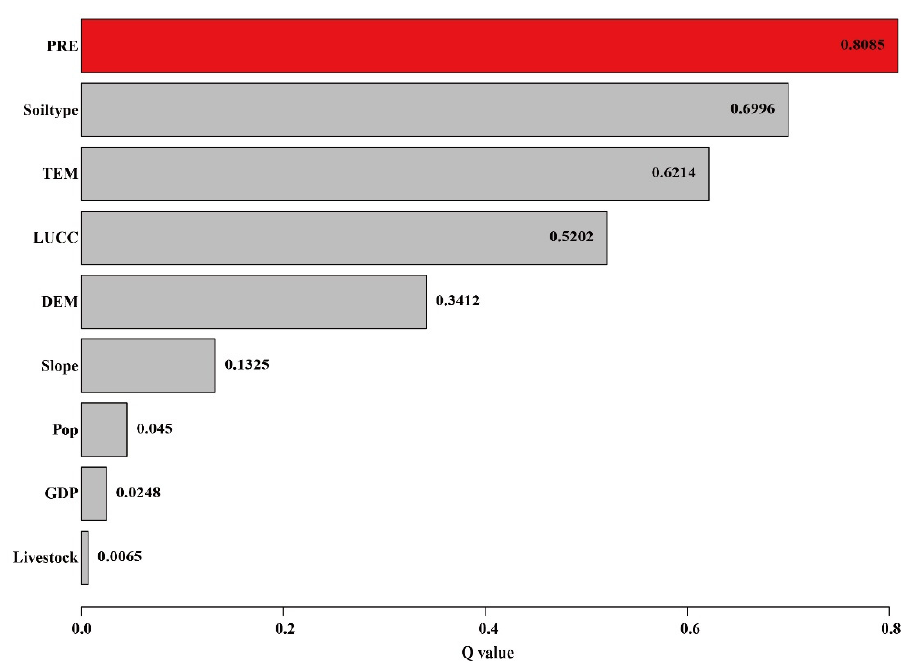
Figure 9. Factor detector results for each factor of the NDVI in Inner Mongolia during 2000–2019.